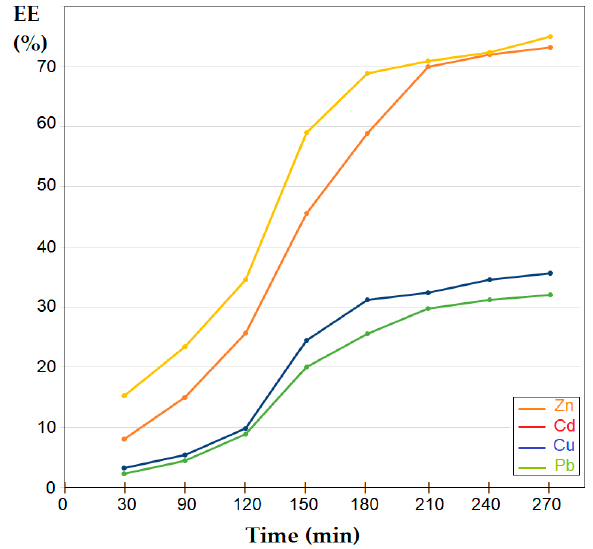
Figure 13. Retention–elution curves when separating the ion mixture with a strongly acidic solution (3 mol/L hydrochloric acid) by nanofiltration (5 bars and 200 mL/min feed solution flow) for the copper–zinc system and the lead–cadmium system from an equimolar 10 − 4 mol/L solution.